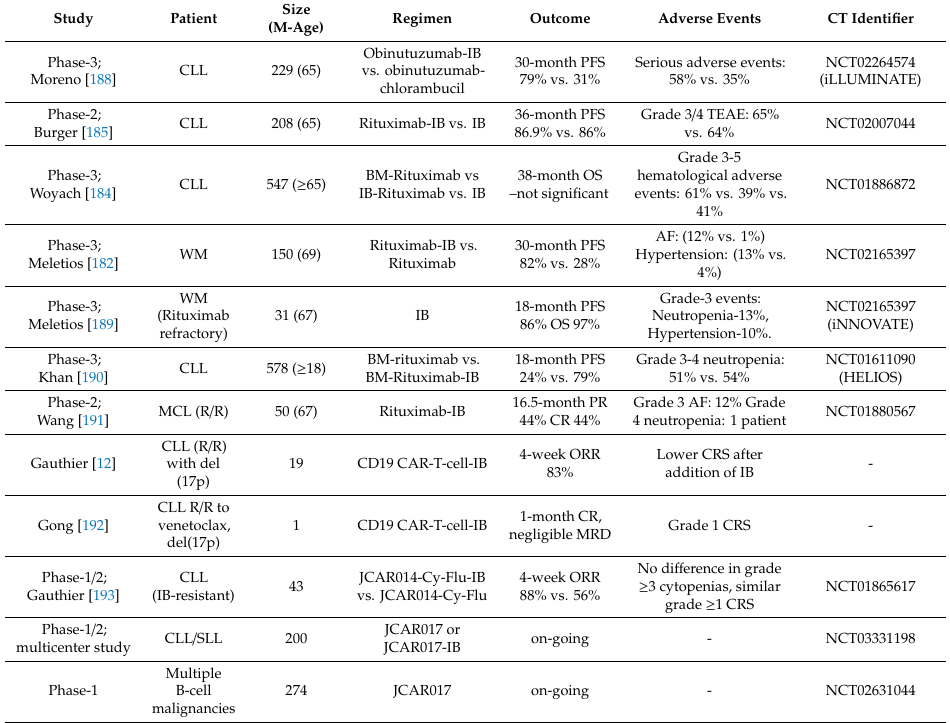
Table 4. Summary of clinical trials representing immunotherapeutic agents with ibrutinib